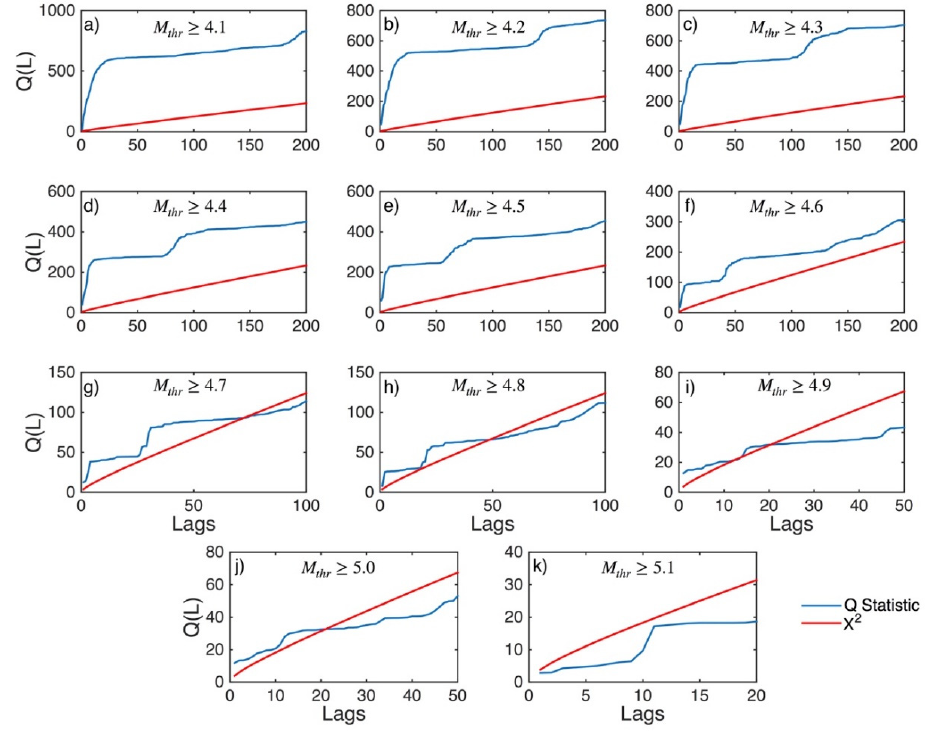
Figure A3. Statistics of Ljung–Box Q-test (blue lines) and the critical values for the X 2 distribution (red lines) for Western Greece and Albania (sub-area 1) for magnitude thresholds ( M thr ) varying from 4.1 to 5.1 (subplots a – k ).